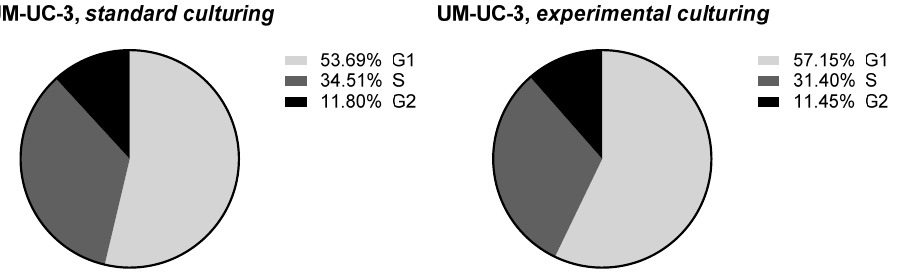
Figure 14. Cell cycle profile observed for UM-UC-3 cells cultured in standard or experimental